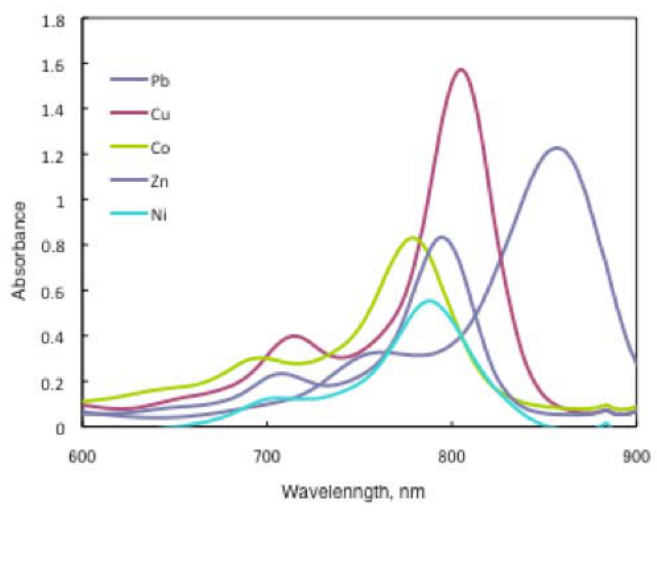
Figure 20 . UV-Vis spectra of 15a